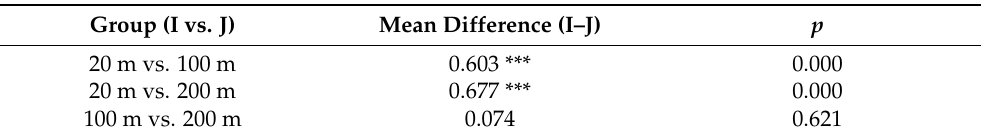
Table 18. Post hoc (LSD) multiple factors comparison analysis of impacts of different viewing distances on perceived depression.